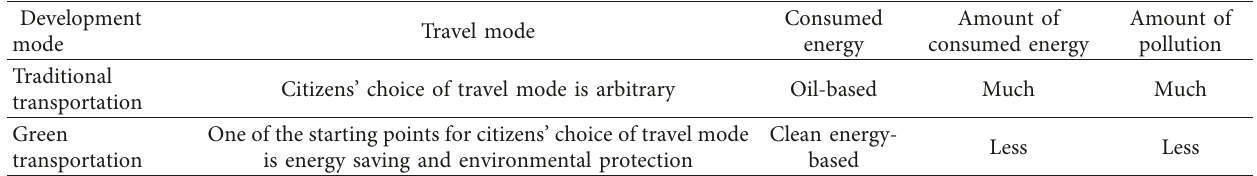
Figure 3: Relationship among concepts related to green economy. Table 1: Differences between green transportation and traditional